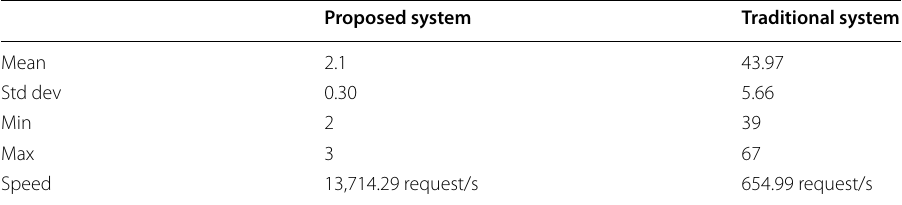
Table 3 Database write evaluation summary